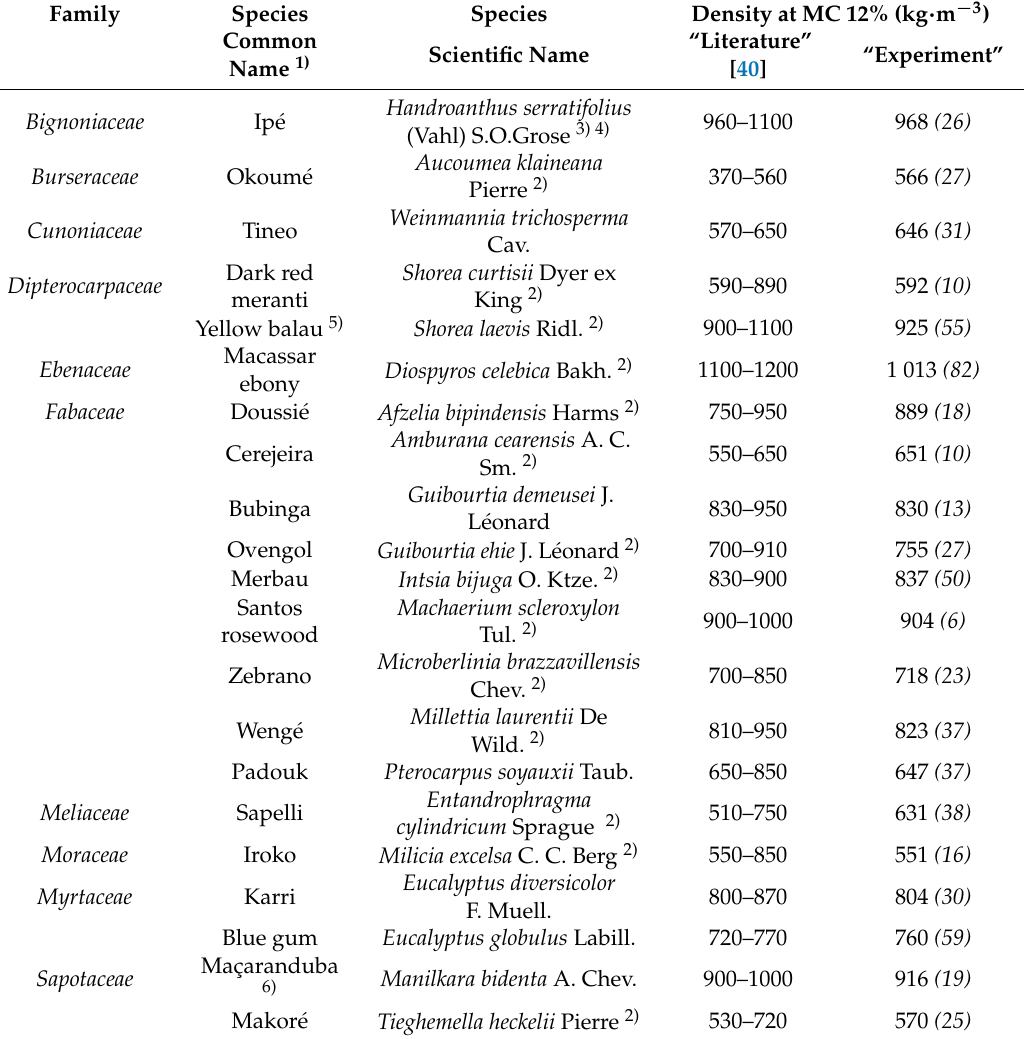
Table 1. Tropical wood species used in the